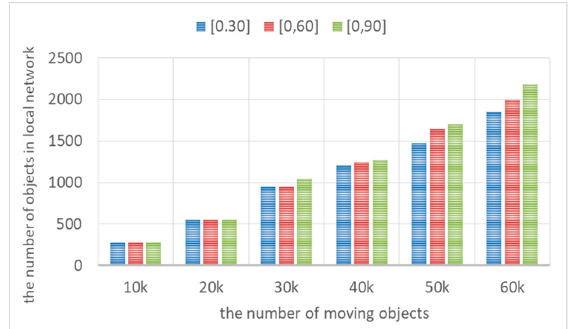
Figure 10. The number of objects in local road networks varies with the number of moving objects in different time